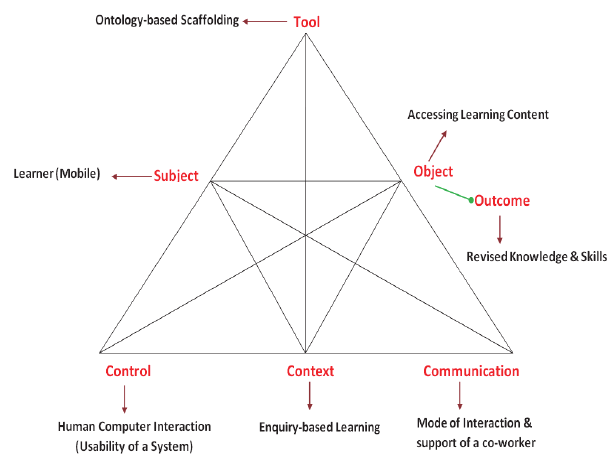
Figure 2 . Technological layer, adopted from